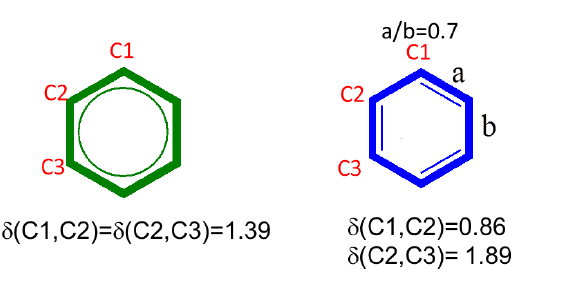
Figure 4. DI values for benzene and cyclohexatriene (with a / b = 0.7) calculated at the B3LYP/6- 311G(d,p) level of